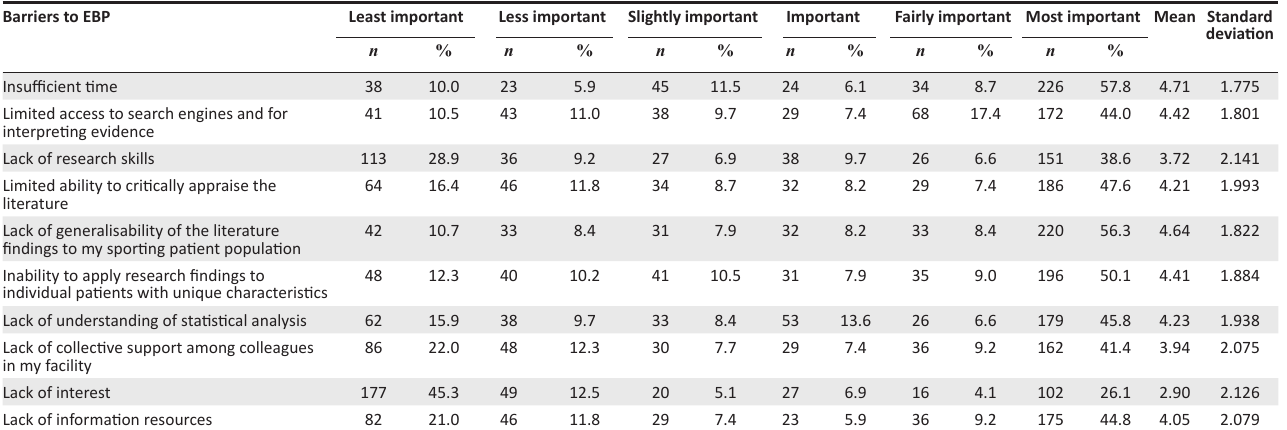
TABLE 5: Barriers to evidence-based practice (EBP) ( n = 391).